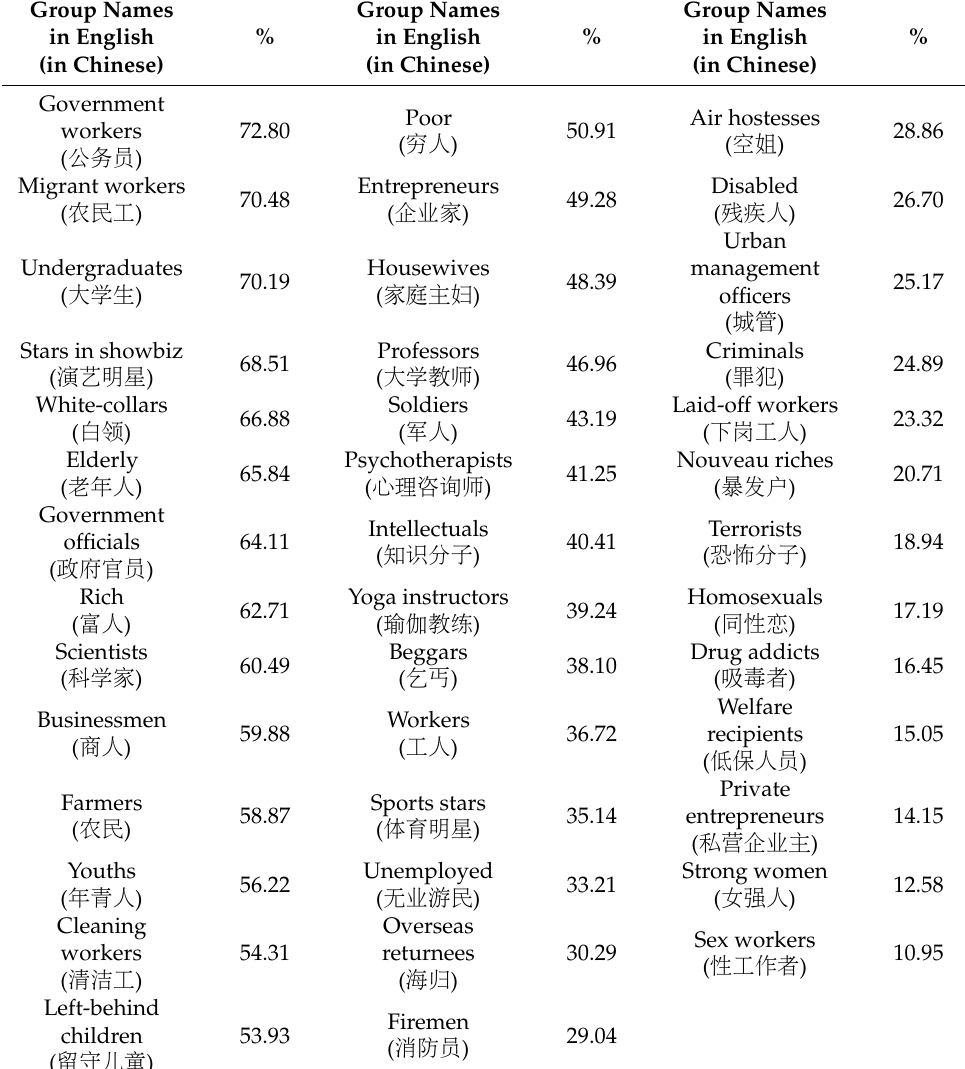
Table 2. Frequency of selected social groups